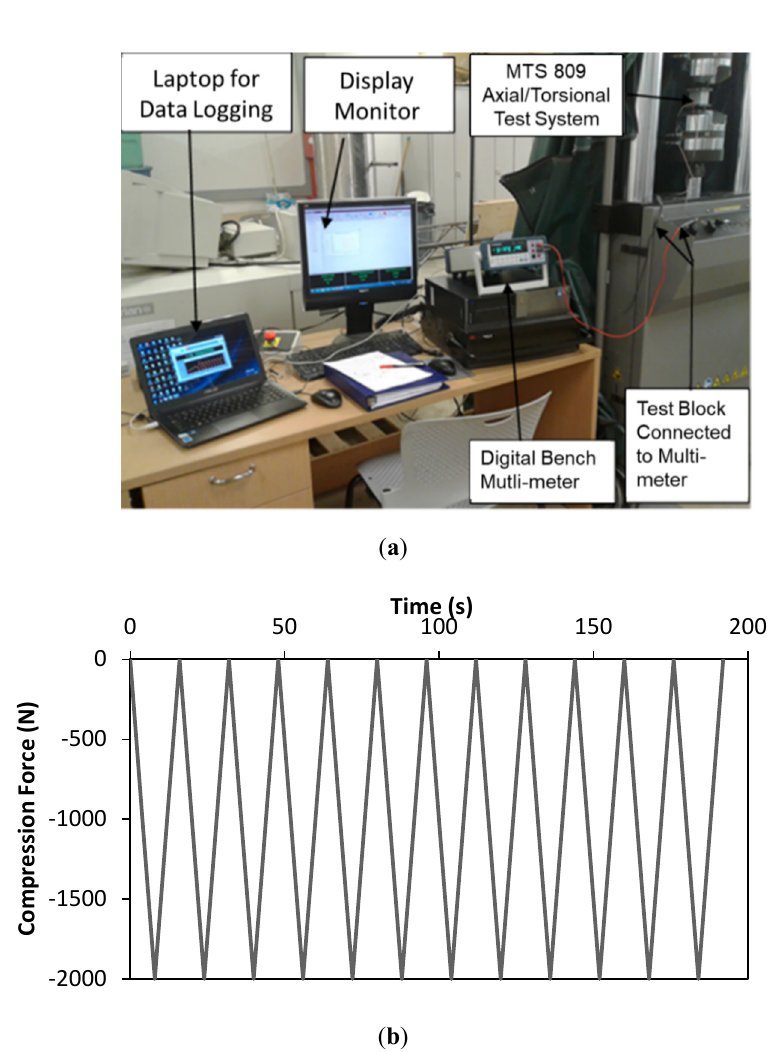
Figure 4. Testing of samples for piezo-responses: ( a ) Laboratory set-up for sample testing; and ( b ) 12-cycle dynamic loading scheme for the test samples.